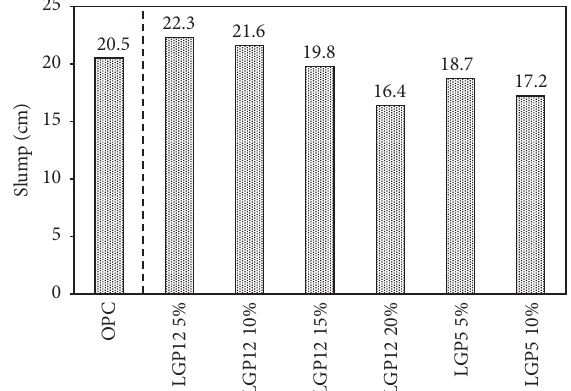
Figure 4: Slump of concrete with LGP